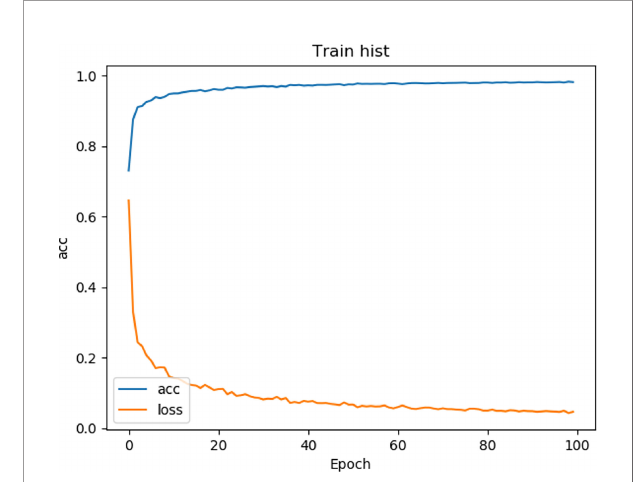
FIGURE 13 | Training result [FR2PAttU-Net (kernel = 3 and